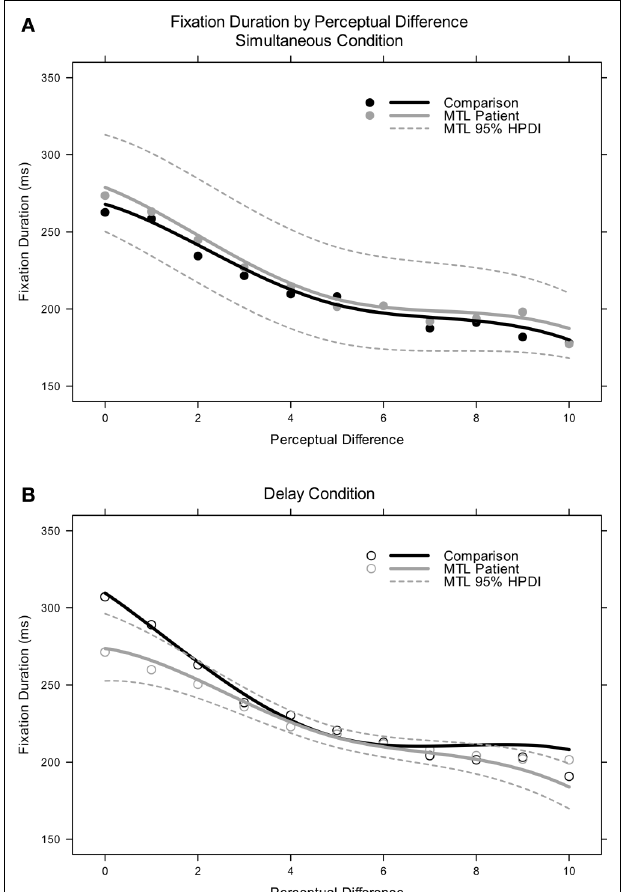
FIGURE 6 | Fixation duration, overall means and model-fi tted curves: (A, top) simultaneous condition; (B, bottom) delayed condition. In (A) , 95% HPDI curves refl ect the main effects of perceptual difference and MTL damage, while in (B) , the HPDI curves refl ect the interactions of those terms with